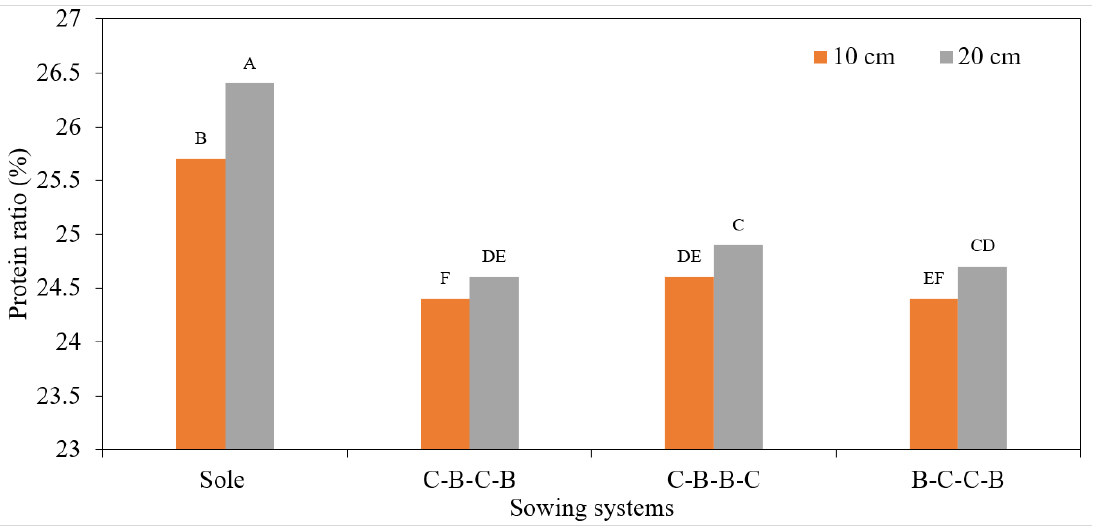
Figure 11. The interactions of maize–white bean sowing systems on protein ratio at Nur Sultan, Kazakhstan research station. Letters on each bar represent significance level at p < 0.05. Note: different letters denote significant differences, while the same letters indicate insignificantly different values.